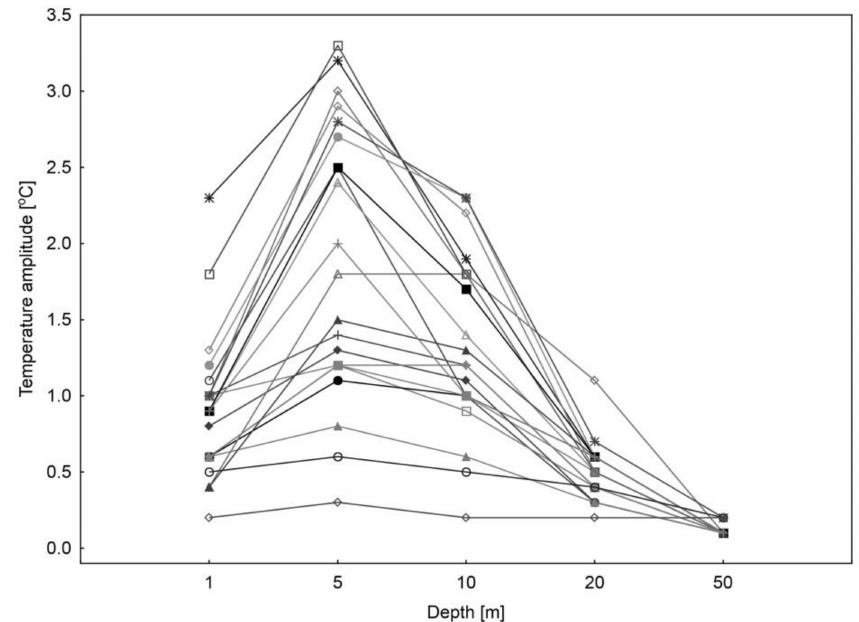
Figure 8. Correlation between water temperature amplitude and depth in Lake Morskie Oko. Temperature profile Type 3. The dates for each line are described in detail in the text above.